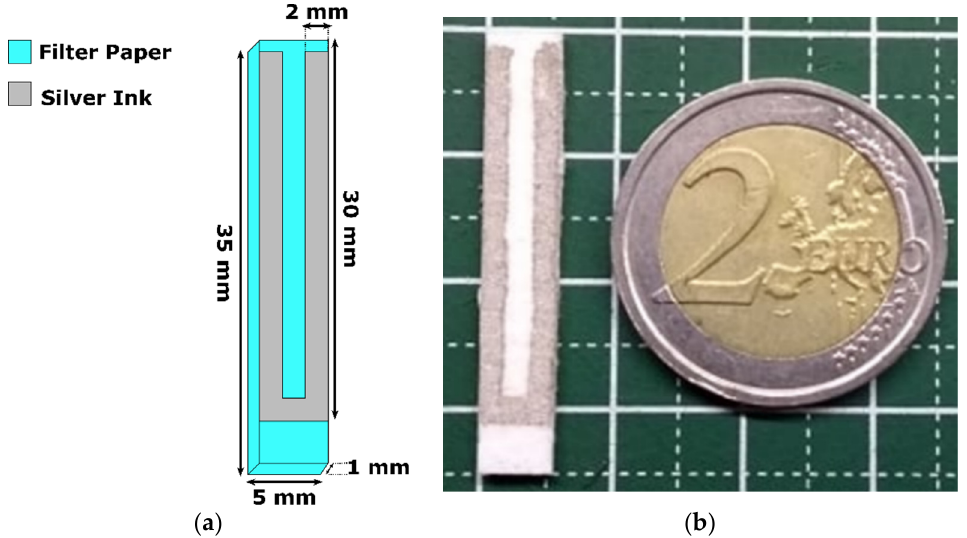
Figure 4. Comparative geometry schematic for sample mini actuator ( a ) Geometry and materials of mini actuator; ( b ) Representation of the silver conductive ink hand printed on top of the cantilever beam and its size compared with a two euro coin.